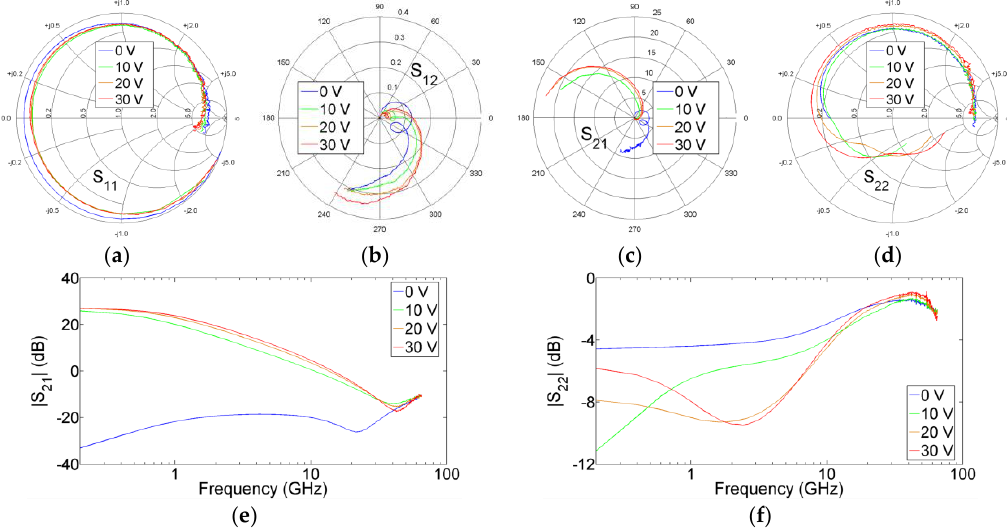
Figure 5. Measured ( a ) S 11 , ( b ) S 12 , ( c ) S 21 , ( d ) S 22 , ( e ) magnitude of S 21 , and ( f ) magnitude of S 22 from 0.2 to 65 GHz for a GaN HEMT at T a = 35 °C and V GS = −3 .1 V for four values of V DS : 0 V, 10 V, 20 V, and 30 V. S 21 at V DS = 0 V is multiplied by a factor of 30 in Figure 4c for better readability.